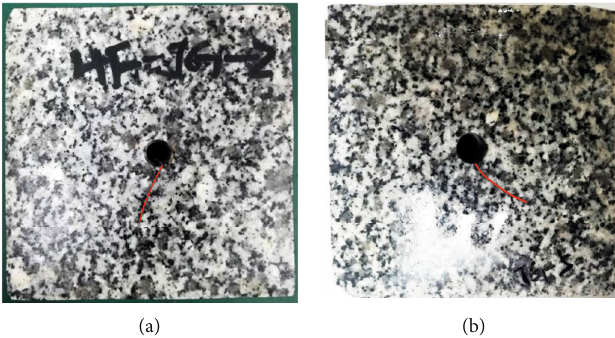
Figure 5: Fracture morphology after the HF tests of specimens: (a) HF-JG-2 and (b) HF-JG-5.